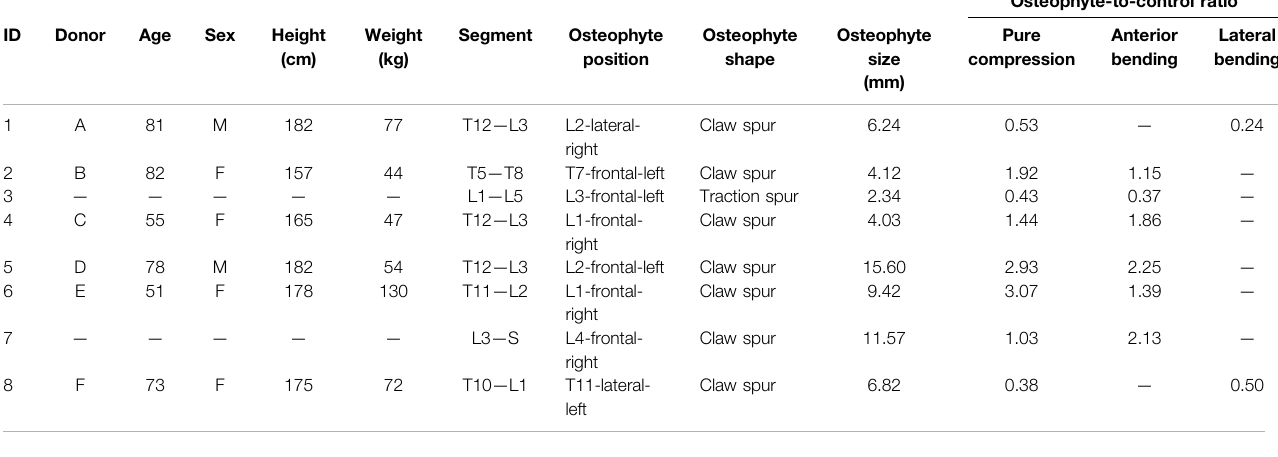
TABLE1| Detailsoftheeightspinalspecimensextractedfromsixvertebralcolumns.Foreachspecimenwerereportedbothosteophytesizeandtheosteophyte – to-control ratio associated with different loading con fi gurations. Two of the donors (B and E) provided two samples each (2 and 3 from B, and 6 and 7 from E).